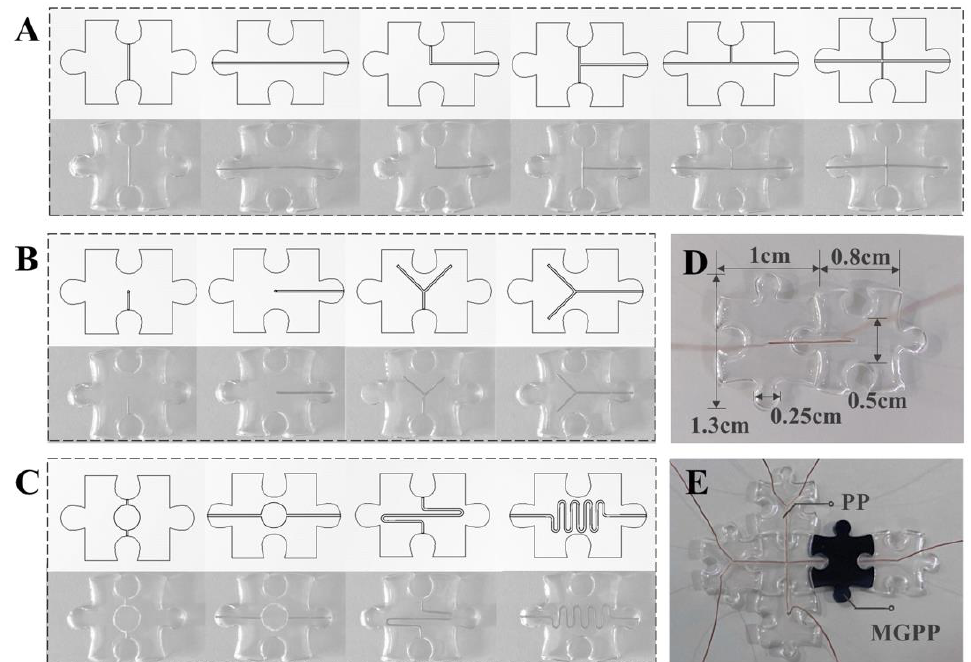
Figure 4. Modular microfluidic design. It includes the design of basic modules for ( A ) connecting flow channels (I/L/T/ + type flow channels) and ( B ) inlet/outlet modules (I type/Y type), and ( C ) functional modules (mixing module, reservoir/reaction chamber, electrochemical detection module). The electrochemical detection module is formed by replacing the PP that forms the reservoir/reaction chamber with MGPP. ( D ) Ink injection to check for leaks. ( E ) Microfluidic electrochemical biosensing platform.